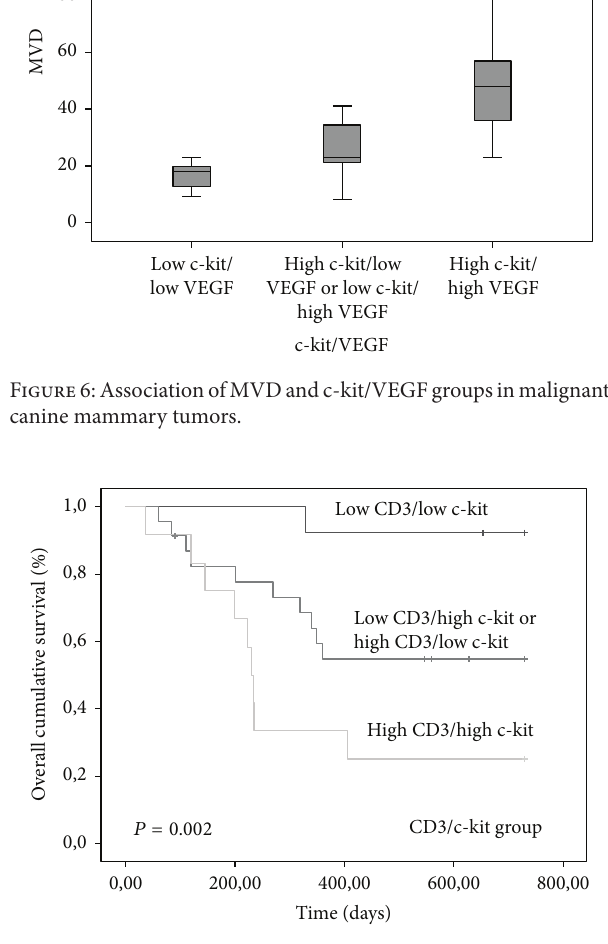
Figure 7: Kaplan-Meier overall survival curves comparing CD3/c- kit group categories in 80 dogs with malignant mammary